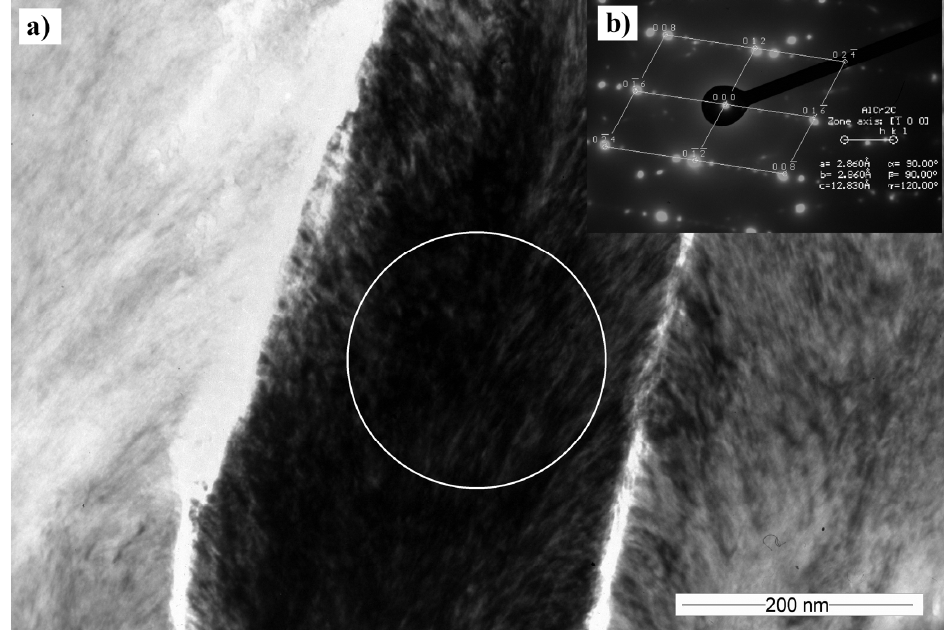
Figure 9. ( a ) TEM cross-sectional BF image of the single Cr 2 AlC crystal on the top layer of the coating, deposited at 90 V; ( b ) Selective area electron diffraction (SAED) obtained in the place marked by the circle.